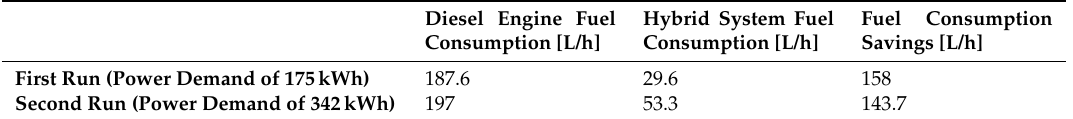
Table 8. Results under a hybrid configuration: Diesel engine 10V 2000 M72 and Battery